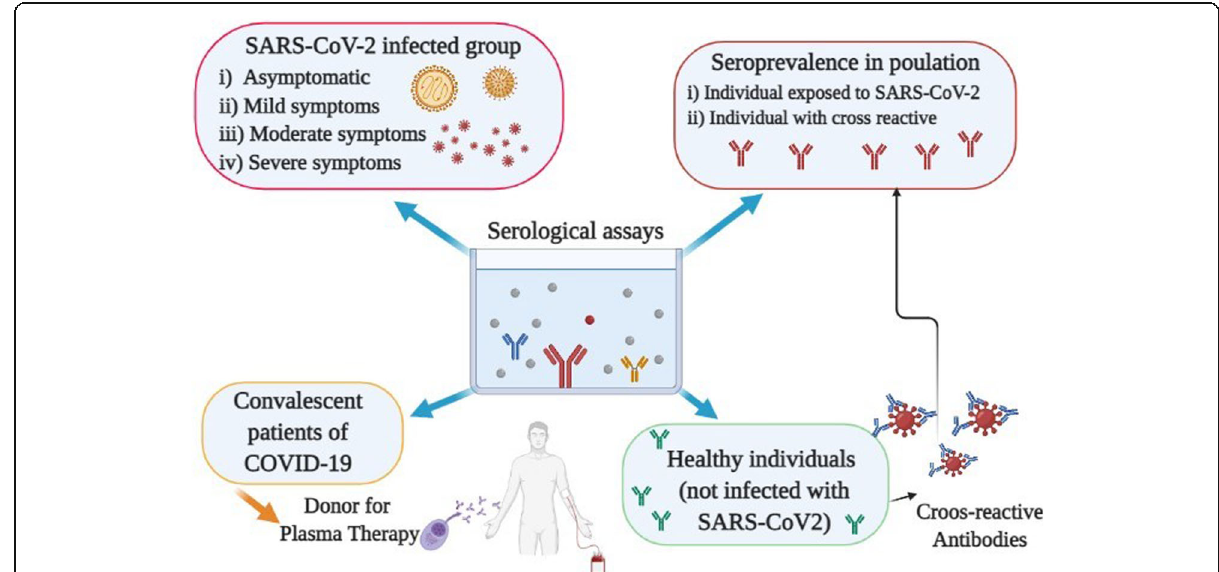
Fig. 2 Schematic diagram of the serological tests used for evaluation of individuals with or without SARS-CoV-2